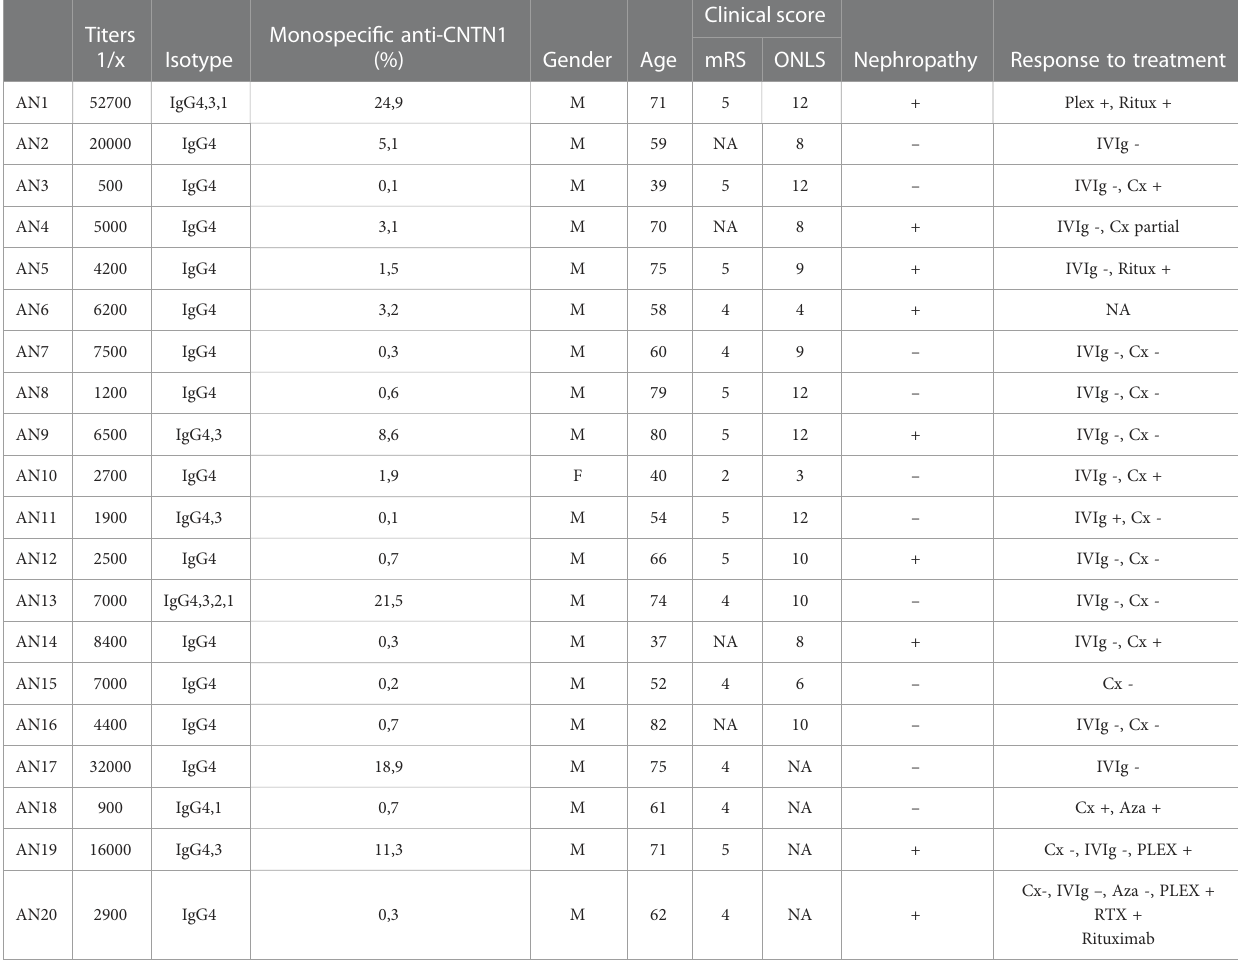
TABLE 1 Antibody titers and clinical features of CNTN1-reactive